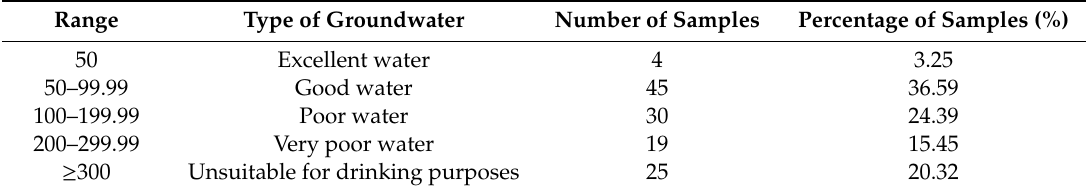
Table 2. Classification of groundwater quality on the basis of the water quality index